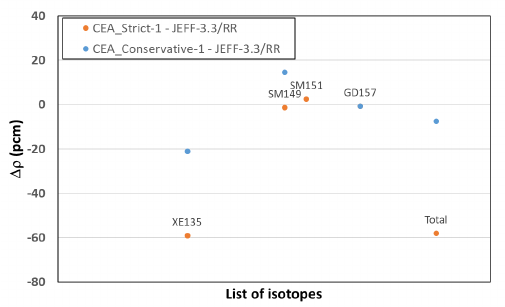
Fig. 24. (Preliminary results) Variation of reactivity for the “Strict 1” and “Conservative 1” FY evaluations in reference of the JEFF-3.3 for a burn up of 1.5